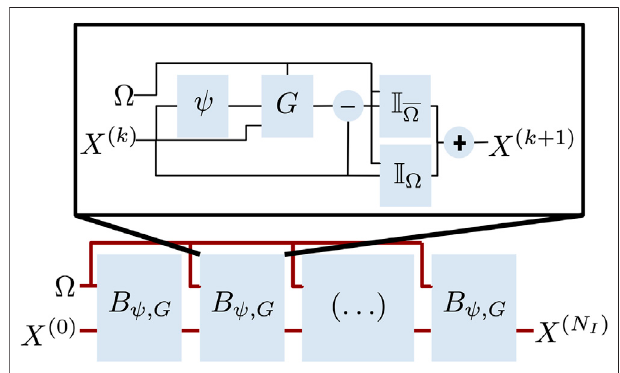
FIGURE 1 | Sketch of the considered end-to-end architecture: We depict the considered N I -block architecture which implements a N I -step interpolation algorithm described in Section 3.2 . Each block B ψ , G refers to iterative fi xed-point update ( Eq. 9 ) or gradient-based update ( Eq. 12 ). Operator ψ is de fi ned through energy representation ( Eq. 8 ), and G refers to the NN-based approximation of the gradient-based update for considered iterative update. This architecture uses as input a mask Ω corresponding to the missing data-free domain and an initial gap- fi lling X ( 0 ) for state X . We typically initially fi ll missing data with zeros for centered and normalized